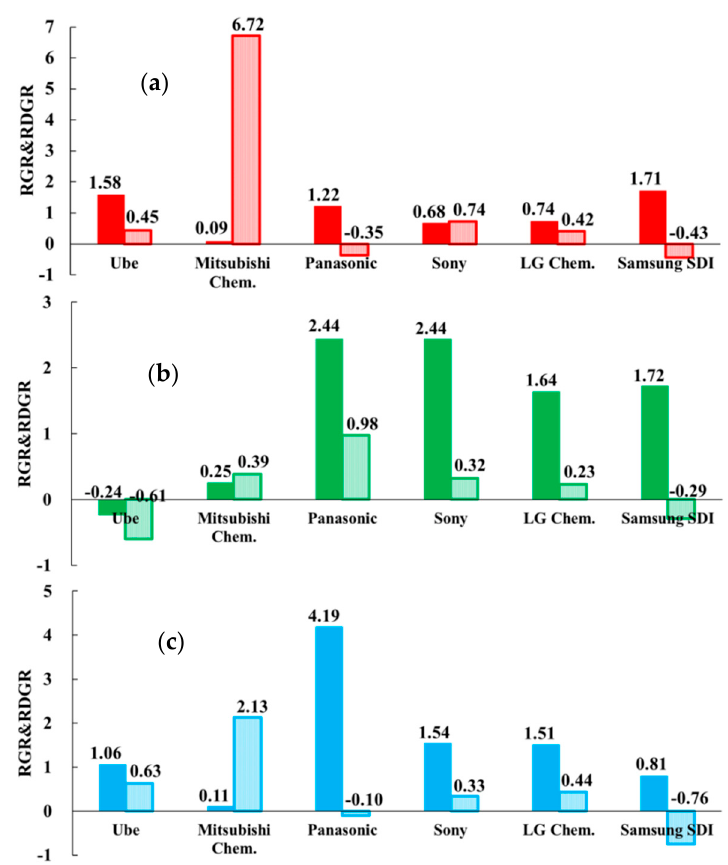
Figure 1. Relative growth rate (RGR) and relative development growth rate (RDGR) of six selected companies in the fields of LIB’s electrolyte technologies: ( a ) H01M10 / 0567 (additives), ( b ) H01M10 / 0568 (lithium salts), and ( c ) H01M10 / 0569 (solvents).